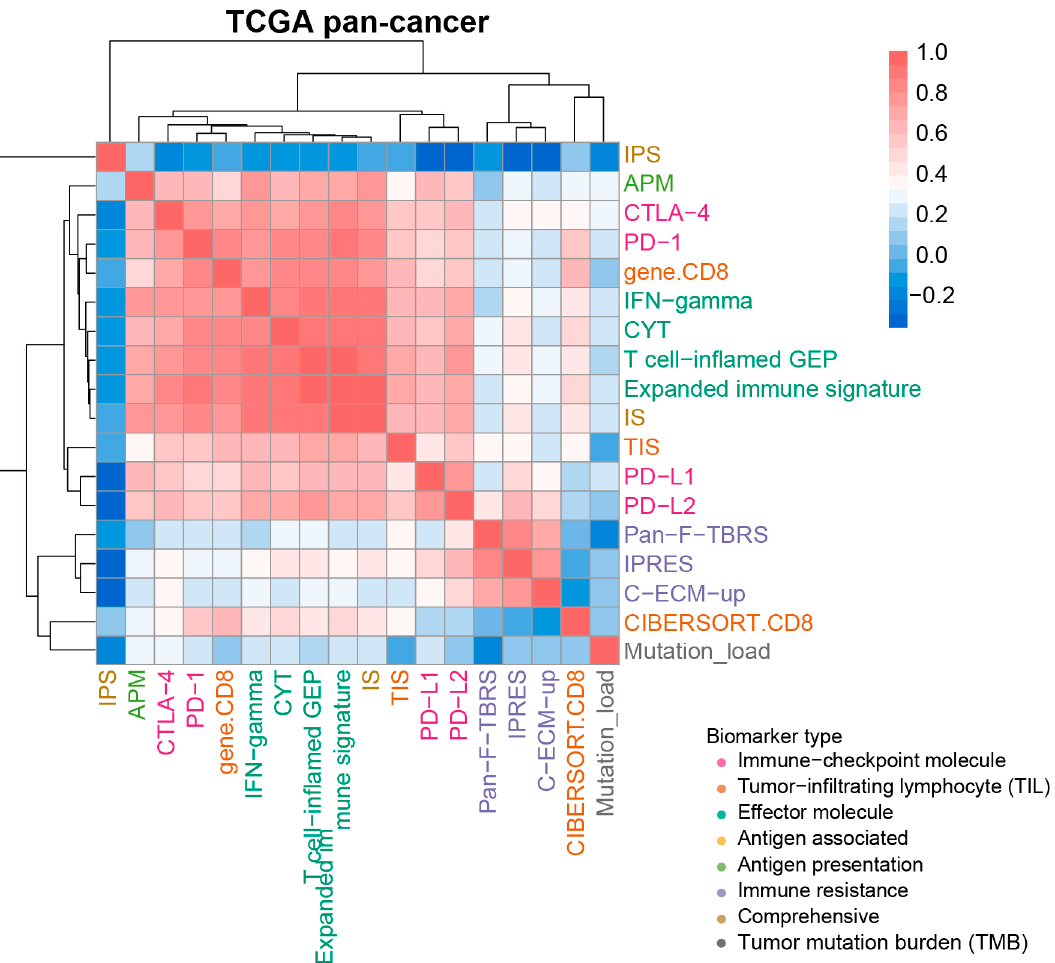
Figure 2. Correlations of transcriptomic biomarkers with ICB response at overall evaluation level. A heatmap displayed the Spearman rank correlation coefficient between any two biomarkers, and demonstrated the hierarchical clustering pattern of various biomarkers based on ~6600 samples from the TCGA pan-cancer cohort. Positive and negative correlations were represented in red and blue, respectively. Biomarkers such as EMT, CRMA, IRP, TIDE and IMPRES were excluded due to them only apply to specific cancer types.